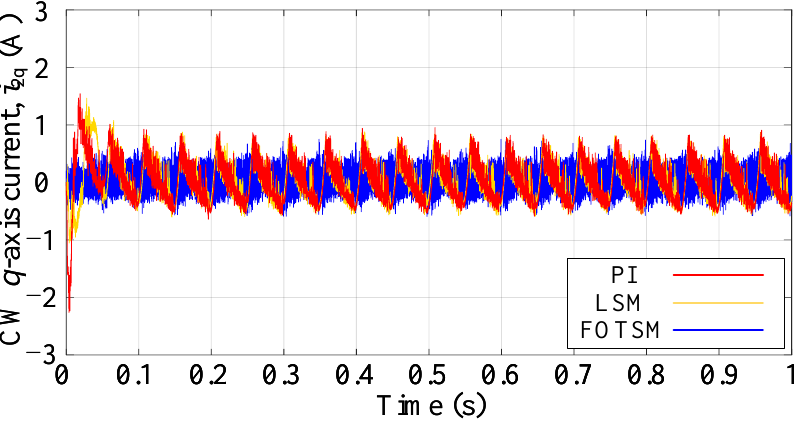
Figure 5. The CW q -axis current responses under PI, LSM, and FOTSM during the start-up process.